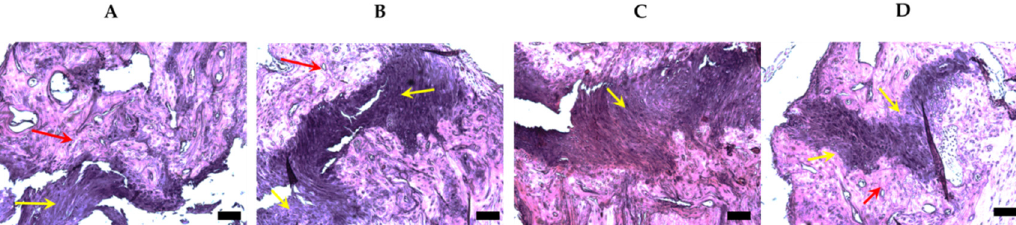
Figure 8. Longitudinal sections of ulna within fracture zones in 24 weeks upon fracturing (H&E staining; 10X). ( A ) PBS (negative control) group, showing multiple bone defects crossing the shear axis of the bones were still present. Bone tissue adjacent to the fracture showed moderate dystrophic changes (red arrow). Immature cartilaginous tissues (yellow arrow) filled in the fracture gaps (calibration = 100 µm); ( B ) polymer groups, showing uneven growths of immature cartilaginous tissues without clear boundaries in the fracture gaps (yellow arrows). There were also moderate to severe dystrophic changes in bone tissue (red arrow) (calibration = 100 µm); ( C ) unmodified MSC groups, showing outgrowth of the immature cartilaginous tissue (yellow arrow) and a large number of polymorphic chondroblasts chaotically distributed within cartilaginous tissue (calibration = 100 µm); and ( D ) modified MSCs with the polymer group, showing prominent osteogenesis and ossification (yellow arrows). Fracture gaps start to be filled with mature bone tissue. No pronounced dystrophic and degenerative changes in the bone sections (red arrow) (calibration = 100 µm).